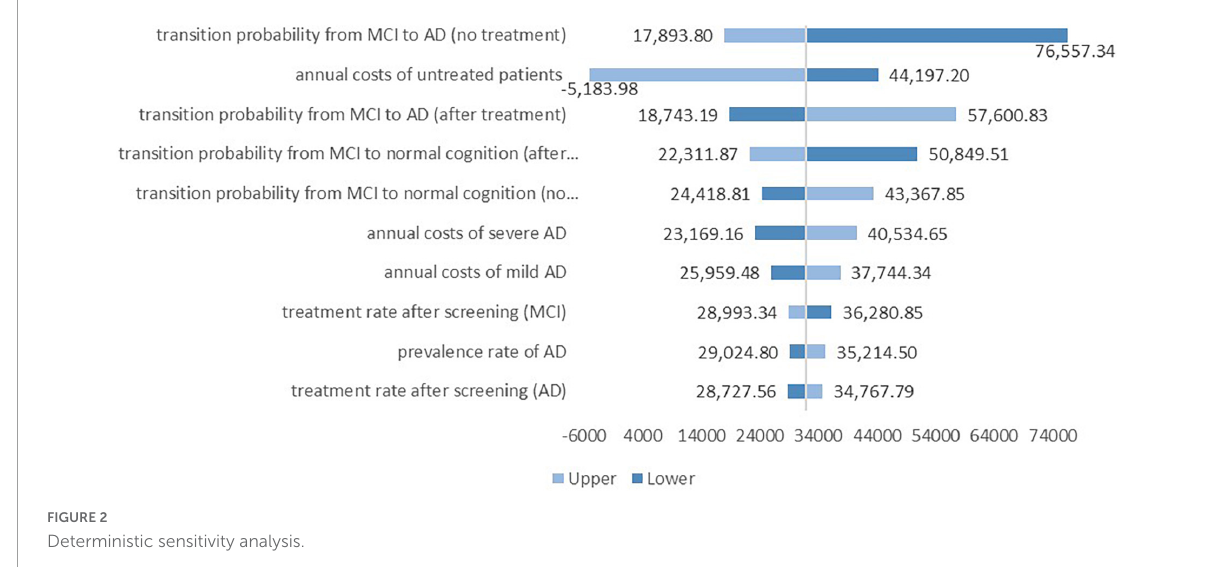
FIGURE2 Deterministic sensitivity analysis.